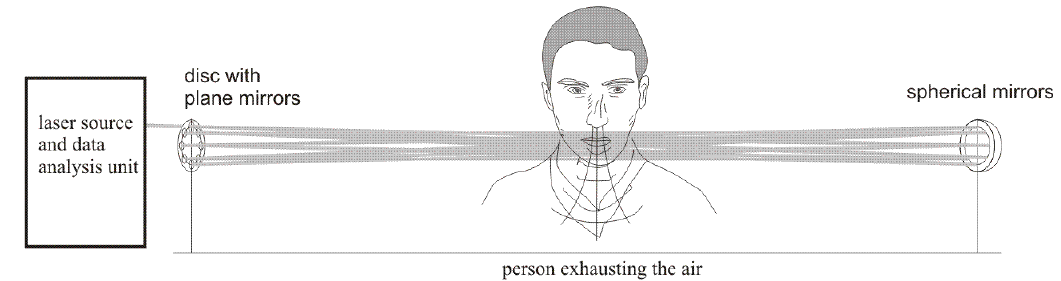
Figure 6. Diagram of the proposed device for alcohol detection in the air exhaled by humans.